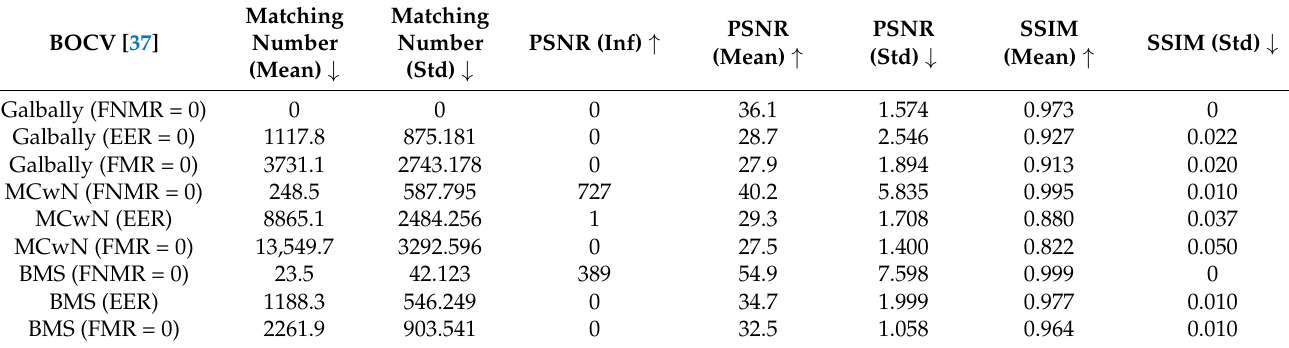
Table 4. Attack performance of BOCV [37].